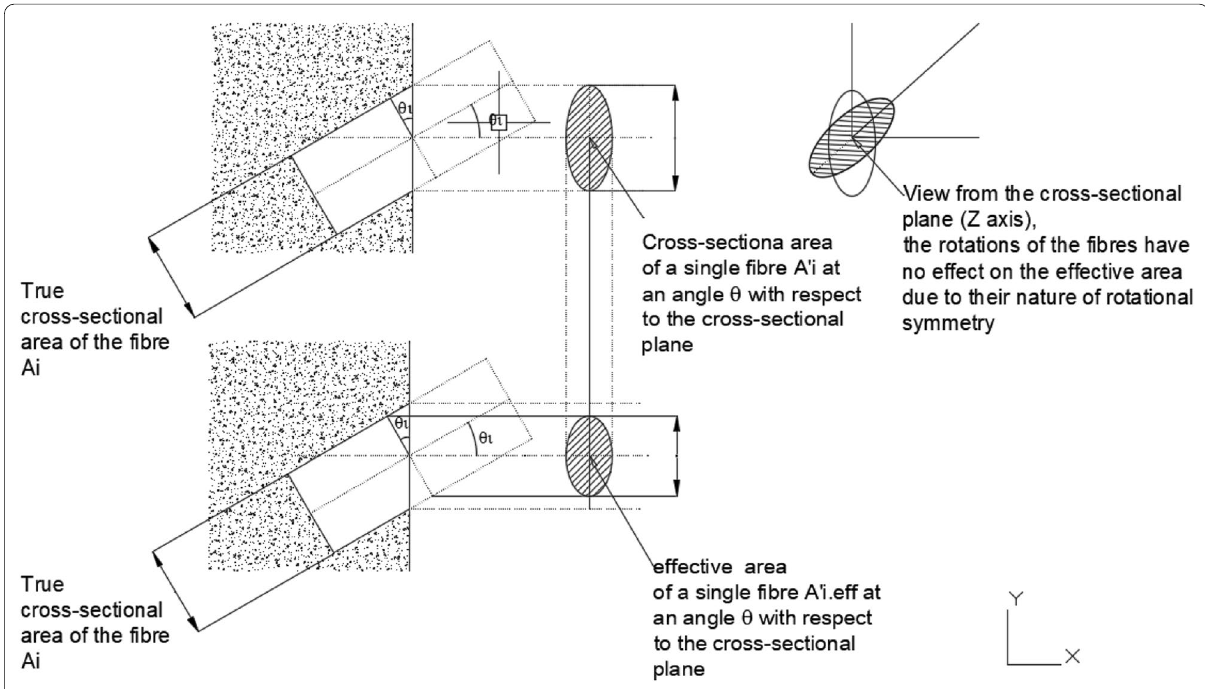
Fig. 2 Effective area and cross-sectional area of a single fibre- a close